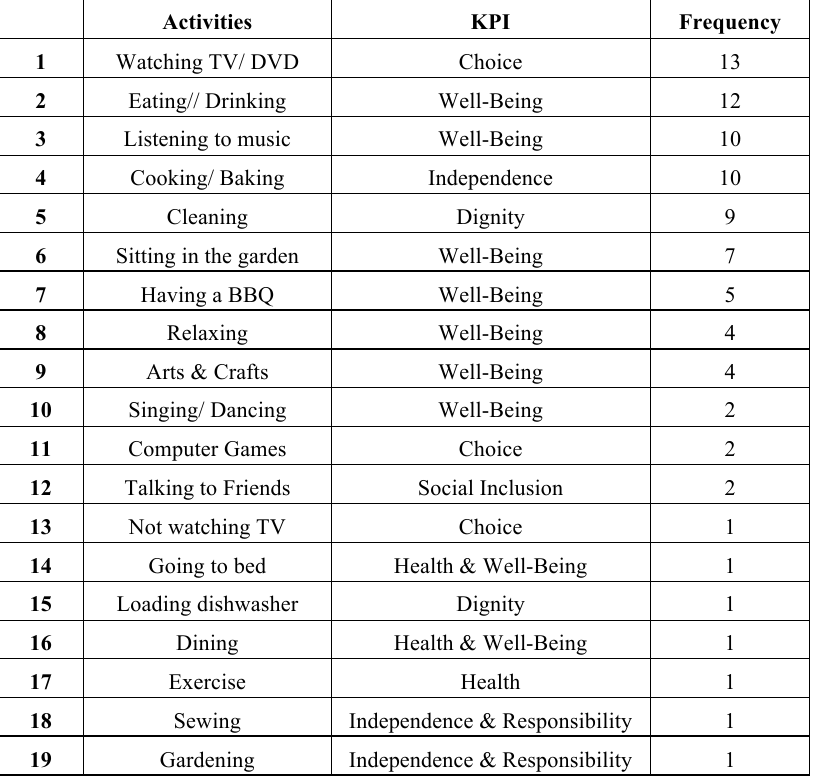
Table 6. Questionnaire responses related to activities ranked by